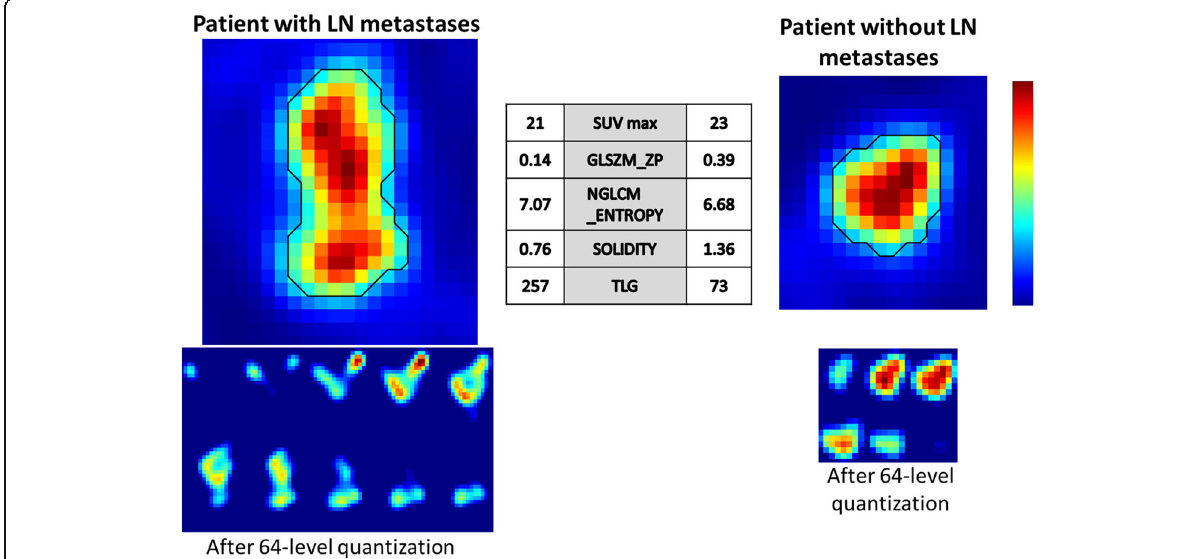
Fig. 4 Example of endometrial tumour with LN metastases (left panel) and endometrial tumour without LN metastases (right panel). Feature values computed on the tumours are displayed in the central table